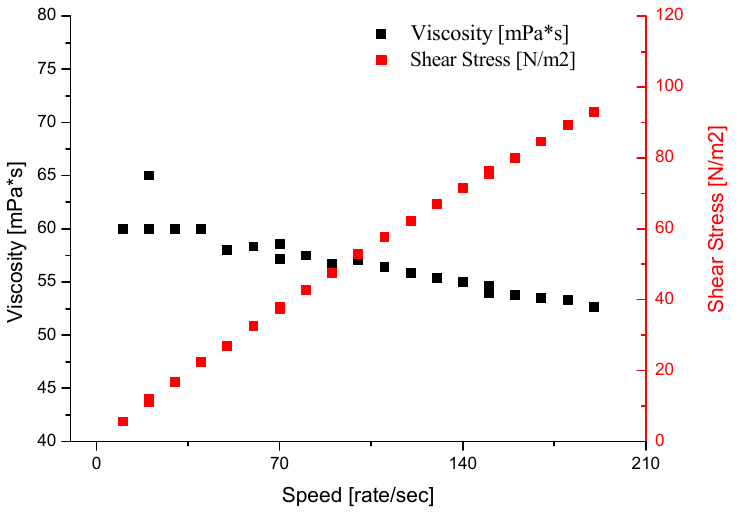
Figure 1. Dynamic viscosity versus shear rate (black curve) and shear stress versus shear rate (red curve) of Imerys W440 binder.